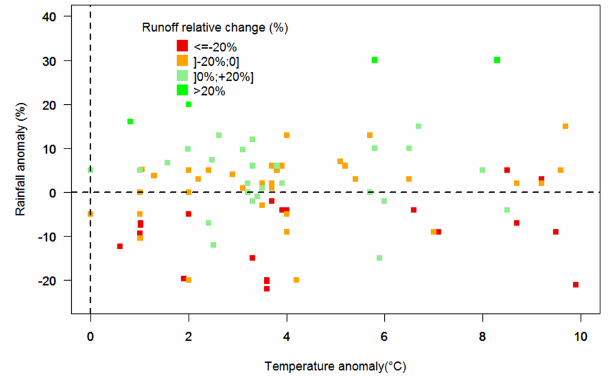
Figure 5. Rainfall ( y axis) and temperature ( x axis) anomalies as- sociated with the runoff relative change (color scale). All the values come from the database.